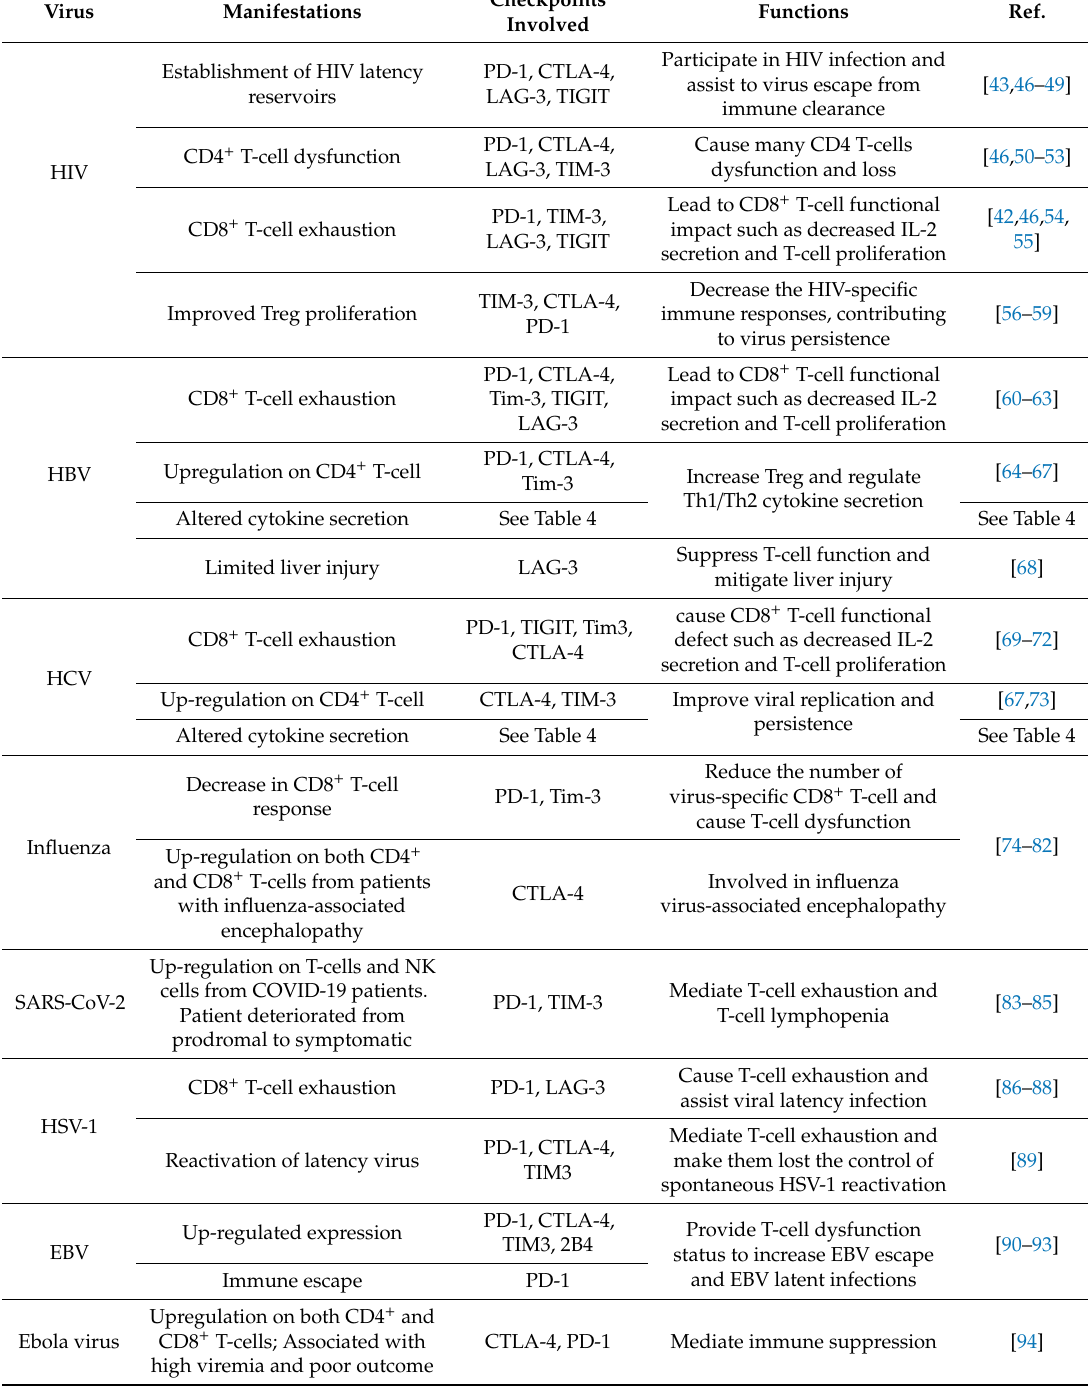
Table 2. Summary of the roles of immune checkpoints in viral